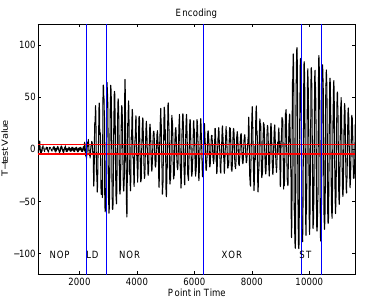
Figure 7: TVLA on encoding a2. The red lines indicate the upper and lower limits of the TVLA threshold ( ±